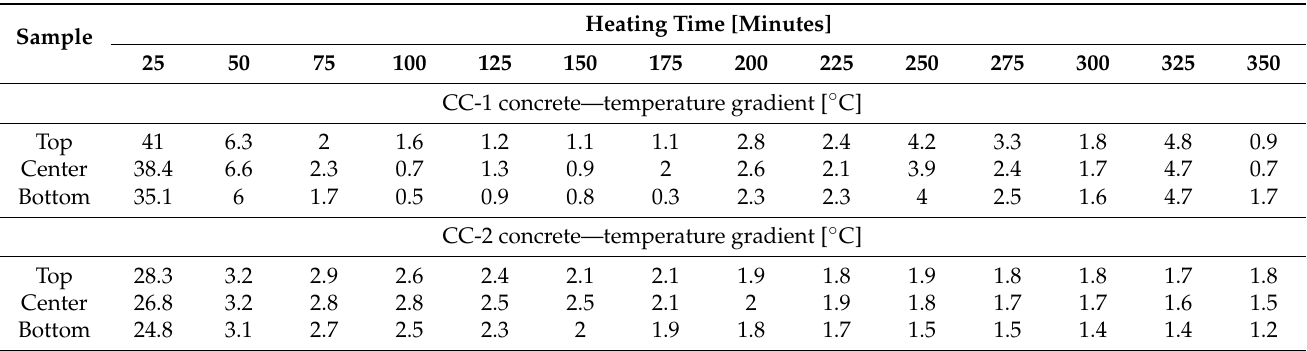
Table 6. Gradient of the average temperature of the CC-1 and CC-2 concrete depending on the test site and heating time.